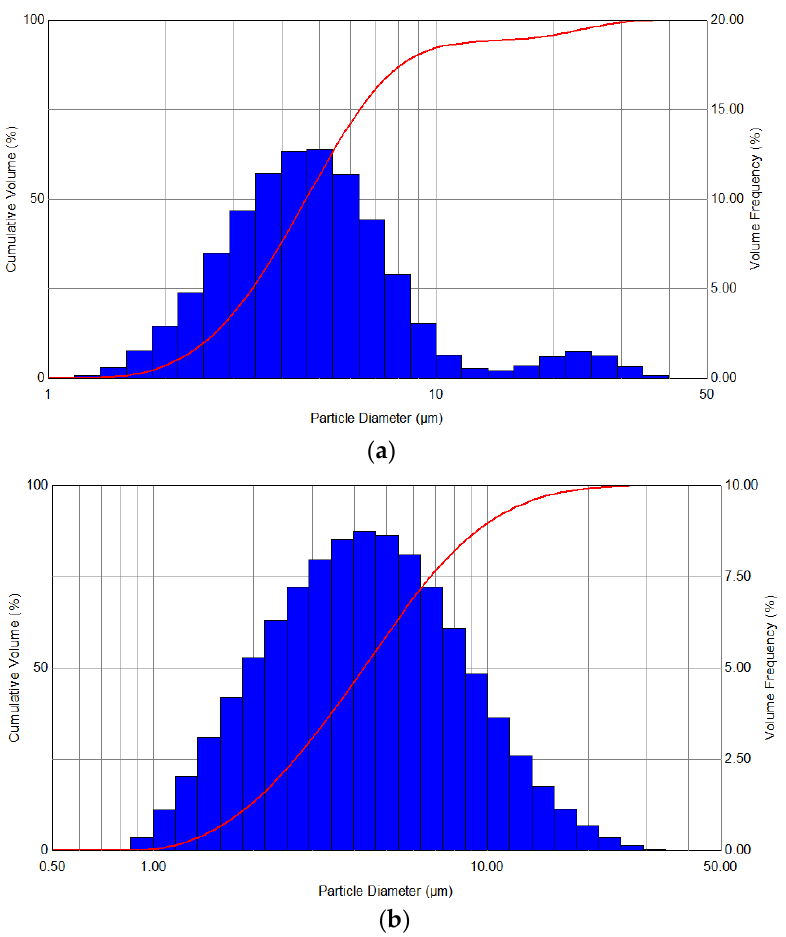
Figure 4. Diameter distribution spectra of the aerosol droplets obtained by spraying at a pressure of 2 bar: ( a ) without heating, ( b ) with